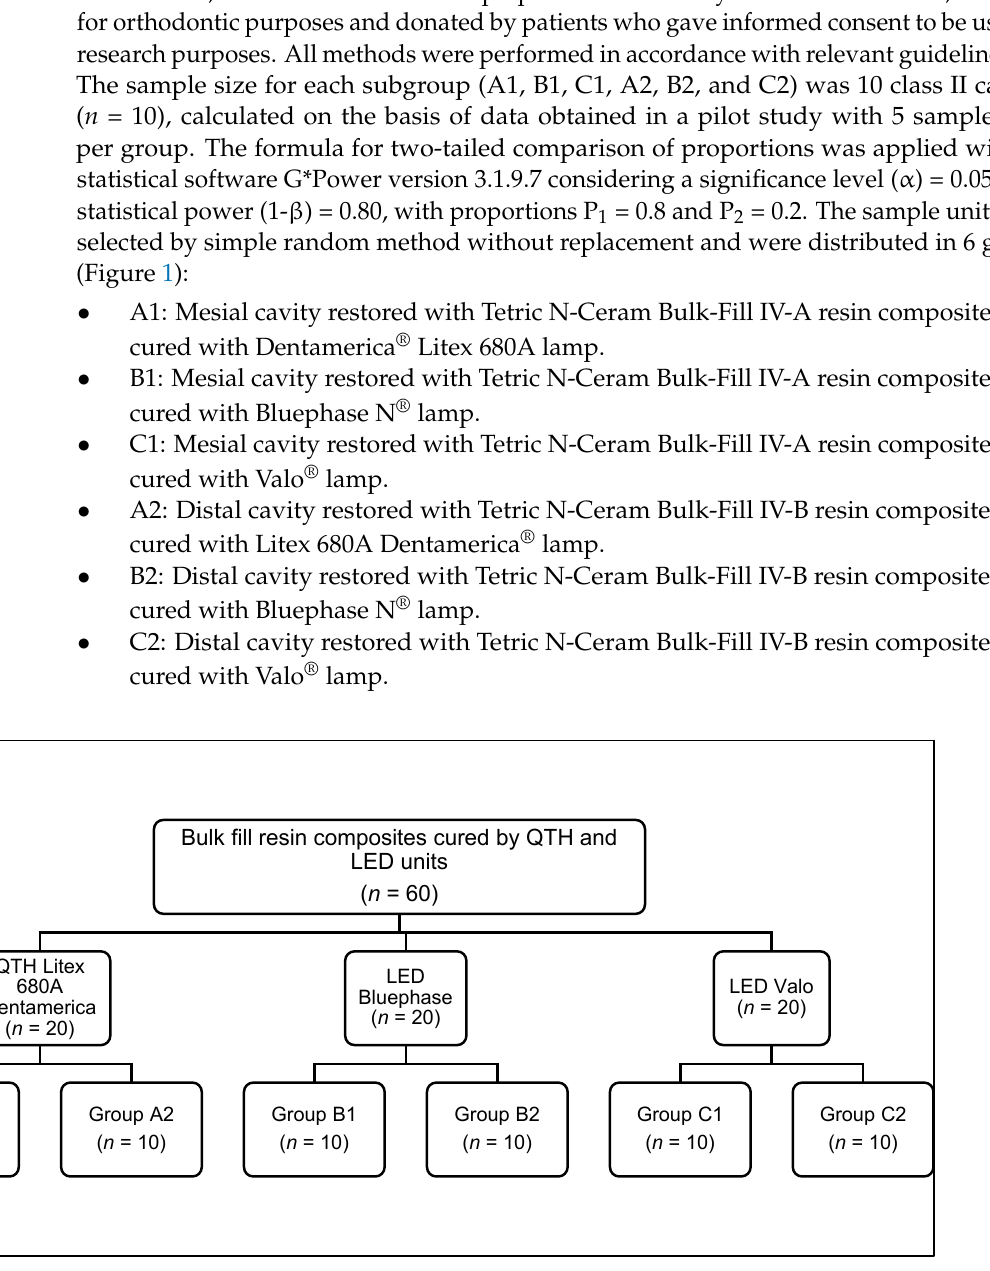
Figure 1. Random distribution of sample units according to type of light-curing unit.